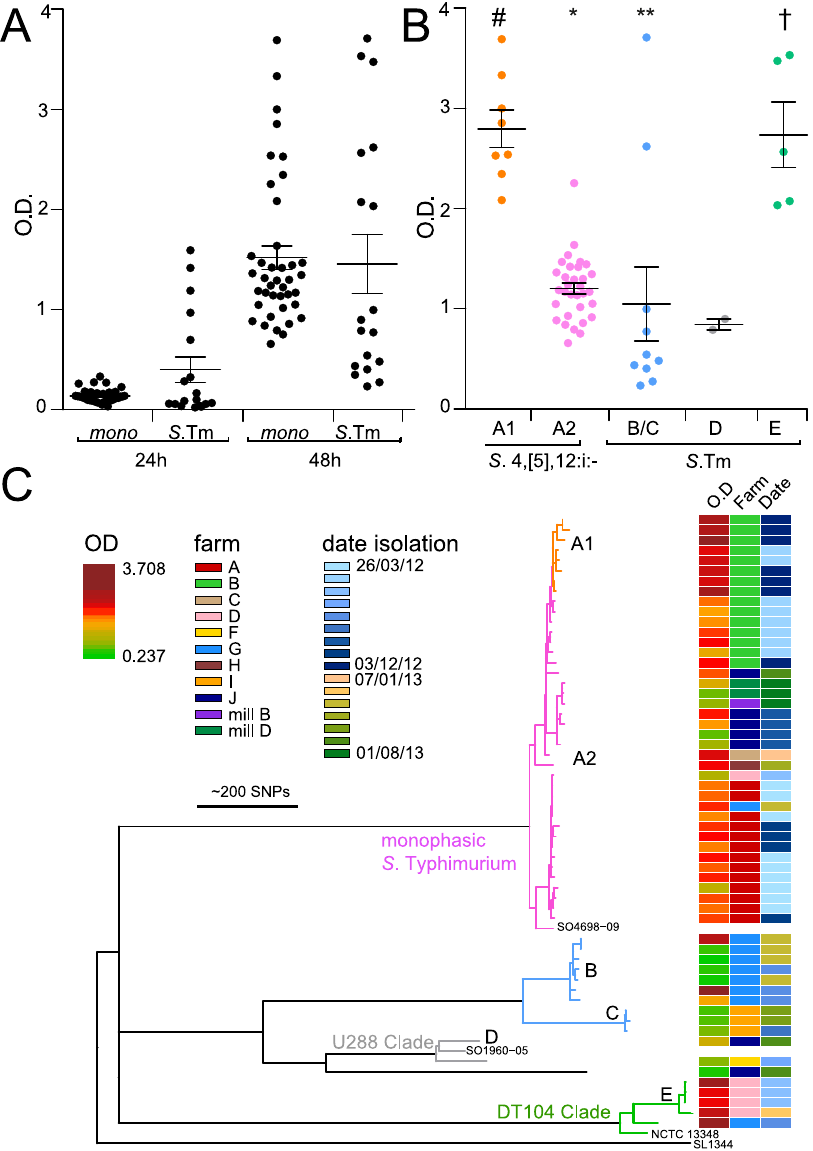
Figure 4. Biofilm formation by S . Typhimurium and S . 4,[5]12:i:- strains and correlation with the phylogeny. The biofilm-forming ability of the isolates was investigated with the microtiter plate assay. ( A ) Scatterplot of the OD 595nm values measured for S . 4,[5],12:i:- and S . Typhimurium after 24 and 48 hours of incubation at 22 °C. ( B ) Comparison of strains from each clade (A1, A2, B–E) to form biofilm. The OD 595nm values measured after 48 hours of incubation were plotted based on the topology of the phylogenetic tree. Pairwise Mann-Whitney test (95% of confidence interval) was performed and p < 0.05 were indicated as; p < 0.05 for all except clade E isolates (DT104-like) (#),: p < 0.05 for all clades ( ** ),: p < 0.05 for all except clade A1 (†). ( C ) Maximum- likelihood phylogenetic tree as Fig. 1 with a subset of isolates for which biofilm formation was determined. The heatmap shows OD 595nm measured after incubation at 22 °C for 48 hours. The clade designation is